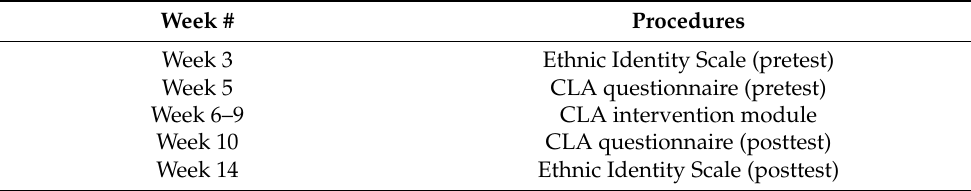
Table 1. Timeline of